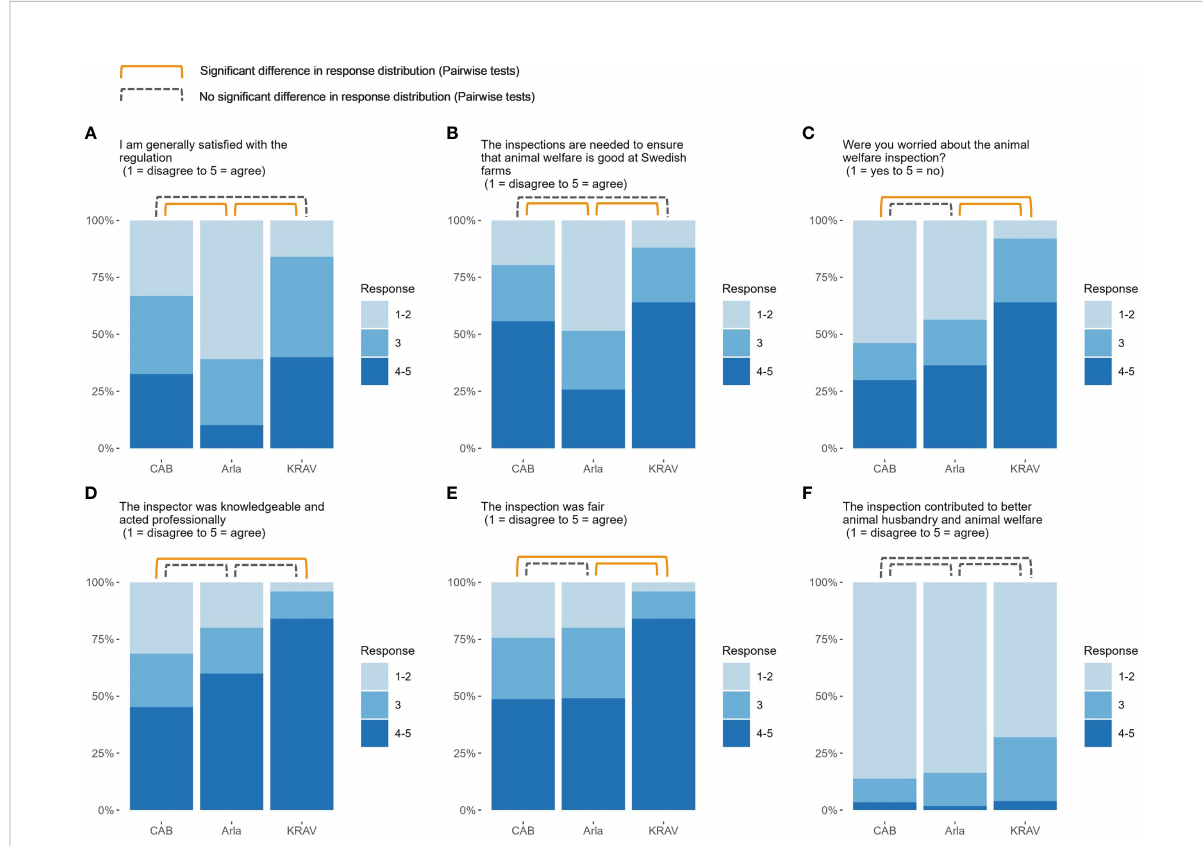
FIGURE 1 Response distributions (in percent) for six of the graded questions (A – F) and for each of the agencies and regulations; CAB (n = 115-163), Arla (n = 55- 69) and KRAV (n = 25). Results from pairwise tests (Fisher ’ s exact test or Chi-squared test) of difference in response distributions are also illustrated, with a solid line indicating a signi fi cant difference ( p <